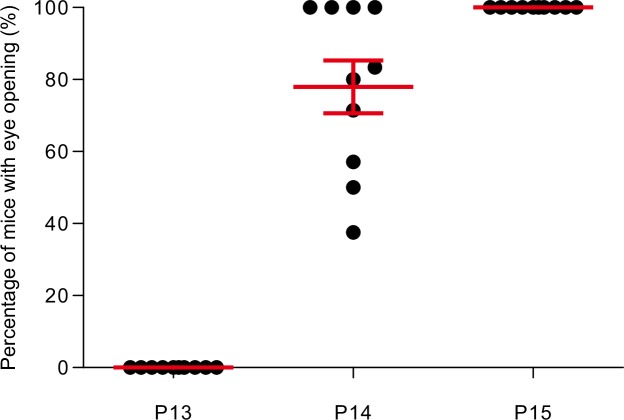
The timing of eye opening in mice.Quantification of mice undergoing eye opening in each litter (n = 10) from P13 to P15. There were no mice with opened eyes at P13. At P14, 77.9% ± 7.4% of mice had opened eyes; at P15, 100% of mice had opened eyes.